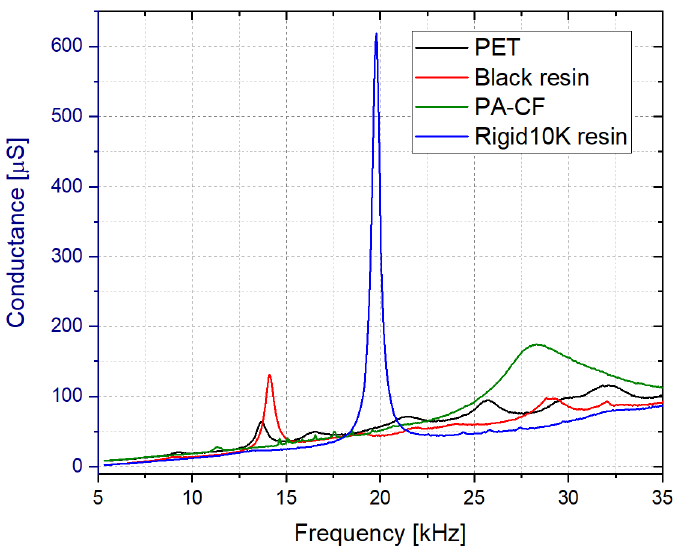
Figure 9. Conductance spectrum measured in water for the cells fabricated with different materials (Lm = 16 mm, Tm = 0.5 mm and Wc = 5 mm).